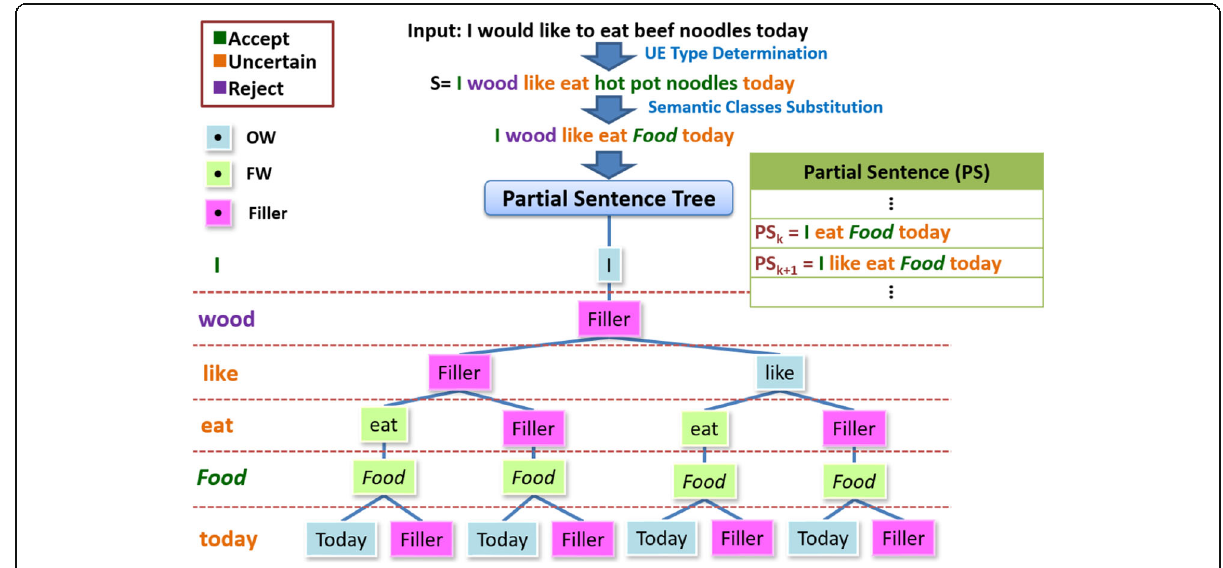
Fig. 5 An example for error-tolerant sentence generation based on partial sentence